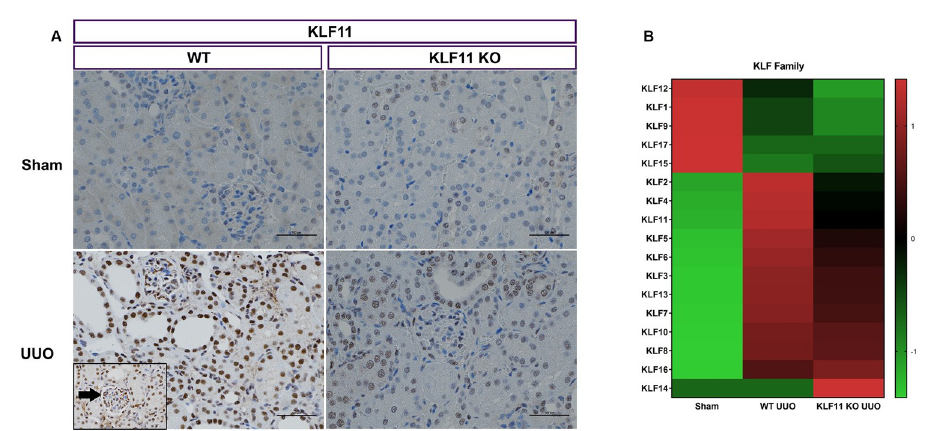
Fig 1. Gene expression of KLF Family members in the murine unilateral ureteral obstruction (UUO) model. (A) Representative histological images of KLF11-stained kidney sections at 400 X magnification, showing WT and KLF11 KO at 9 days after the UUO/Sham surgery. Tubular epithelial cell nuclei show strong positive staining (brown). Glomerulus (arrow, inset) shows focal positive staining within visceral epithelial cells. Scale bar represents 100 microns. (B) Heatmap. Color scale shows high and low expressions as red and green, respectively.